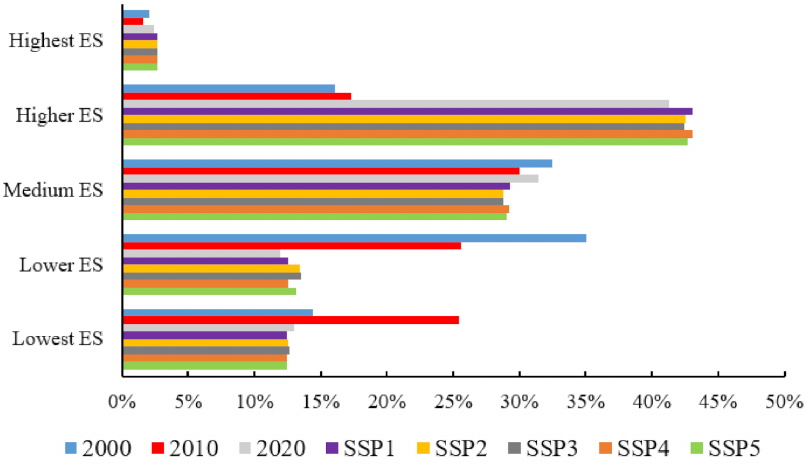
Figure 6. Percentage of each ecosystem service level during 2000 to 2030.